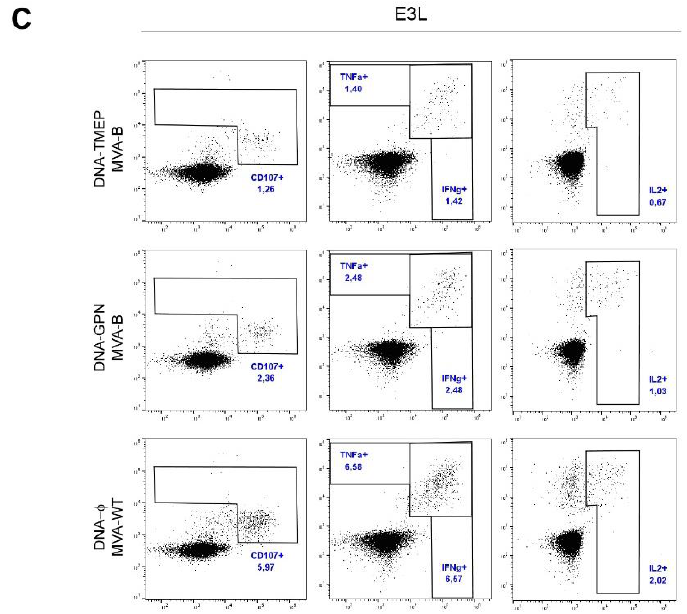
Figure 5. VACV vector E3-specific CD8 T cell immune responses elicited in spleen after prime/boost immunization of mice with TMEP-B construct and MVA-B virus. ( A ) Magnitude of the E3-specific CD8 T cell immune responses measured at 10 days post-boost by ICS assay after stimulation of splenocytes from immunized animals with VACV E3 peptide. The magnitude in each group indicates the sum of the percentages of CD8 + T cells secreting CD107a and/or IFN- γ and/or IL-2 and/or TNF- α against E3 peptide. Data are background subtracted. *** p < 0.001. ( B ) Functional profile of the E3-specific CD8 T cell responses in the different immunization groups. Positive combinations of the responses are represented on the x axis, whereas the percentages of the functionally distinct cell populations within the total CD8 T cells are shown on the y axis. Responses are grouped and colour-coded based on the number of functions. C: CD107a; I: IFN- γ ; 2: IL-2; T: TNF- α . ( C ) Flow cytometry profiles of vaccine-induced CD8 T cell responses in spleen against E3 peptide in the groups immunized with the heterologous combinations DNA/MVA.